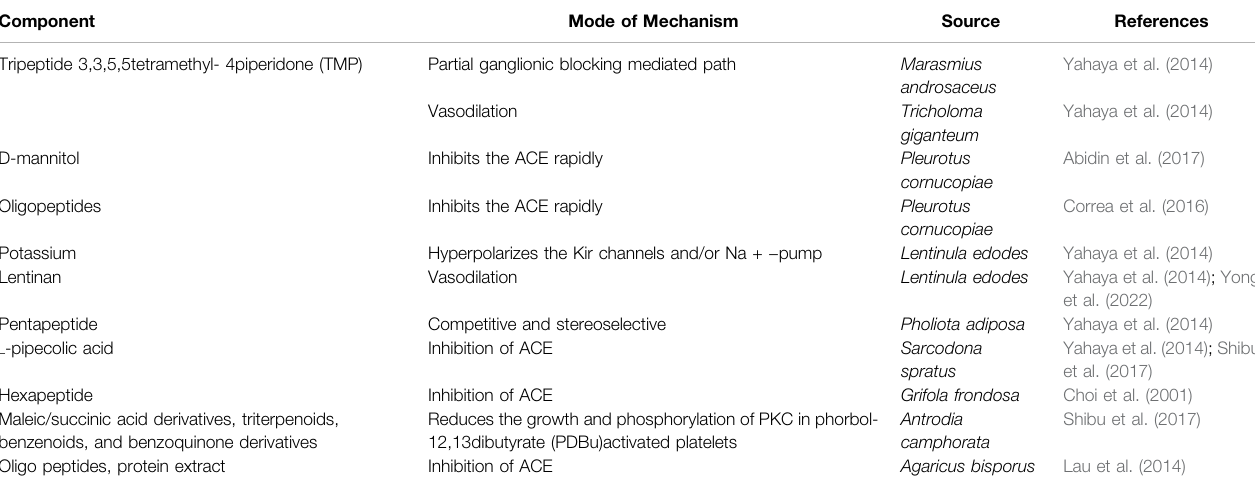
TABLE 5 | Antihypertensive mechanism and bio components from the edible